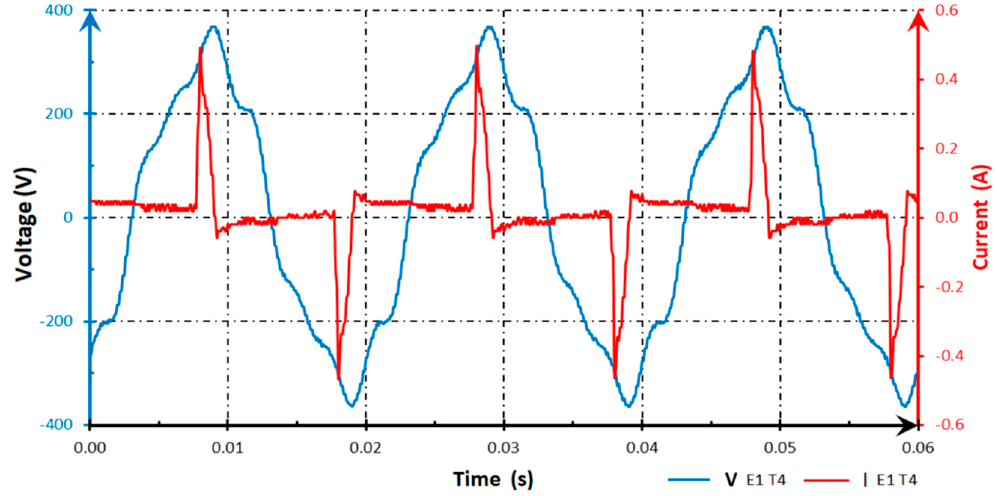
Figure 5. The voltage and current course during the E1 light source test with the level of Test T4. Simultaneously, in Figures 6 and 7, results of changes in power factor (PF) and crest factor (CF) in the function of tests are presented.